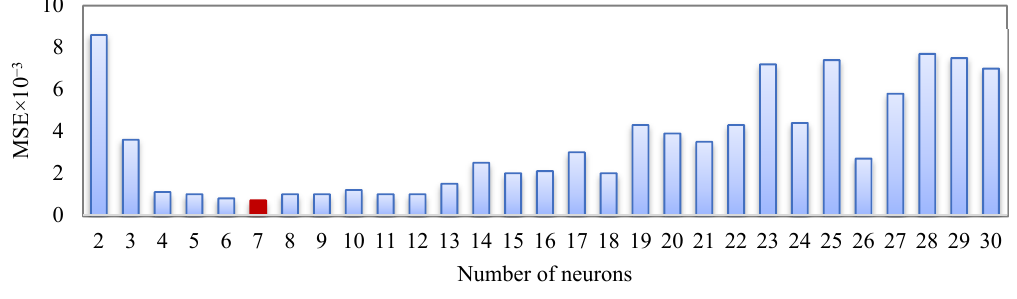
Figure 3. The optimum number of neurons in the hidden layer.